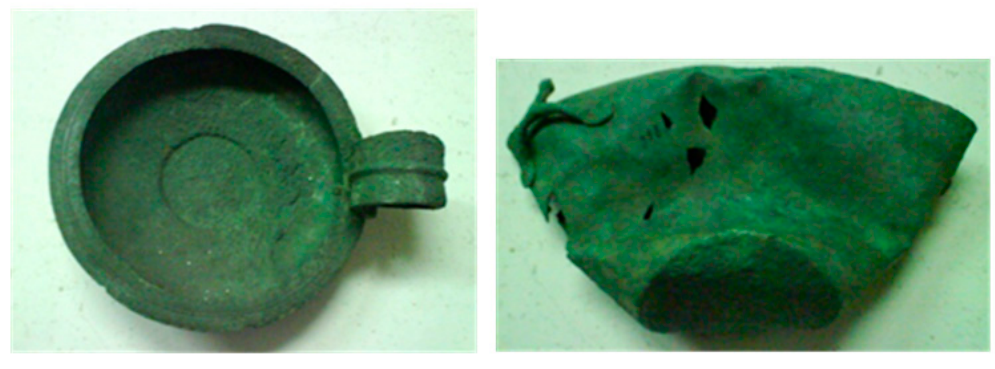
Figure 3. Copper-based Naue II swords of unknown provenance (Nos. 9885 and 13905), a bowl (No. 11934) and a large basin (No. 11949) from Peloponnese, Argolid, dated back at the LBA (14th–12th century BC).